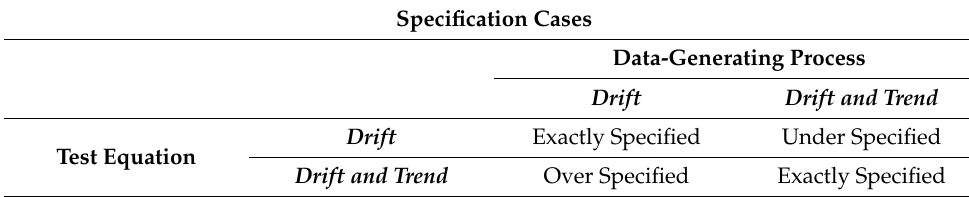
Table 2. Specific Cases of Data Generating Process and Test Equation.